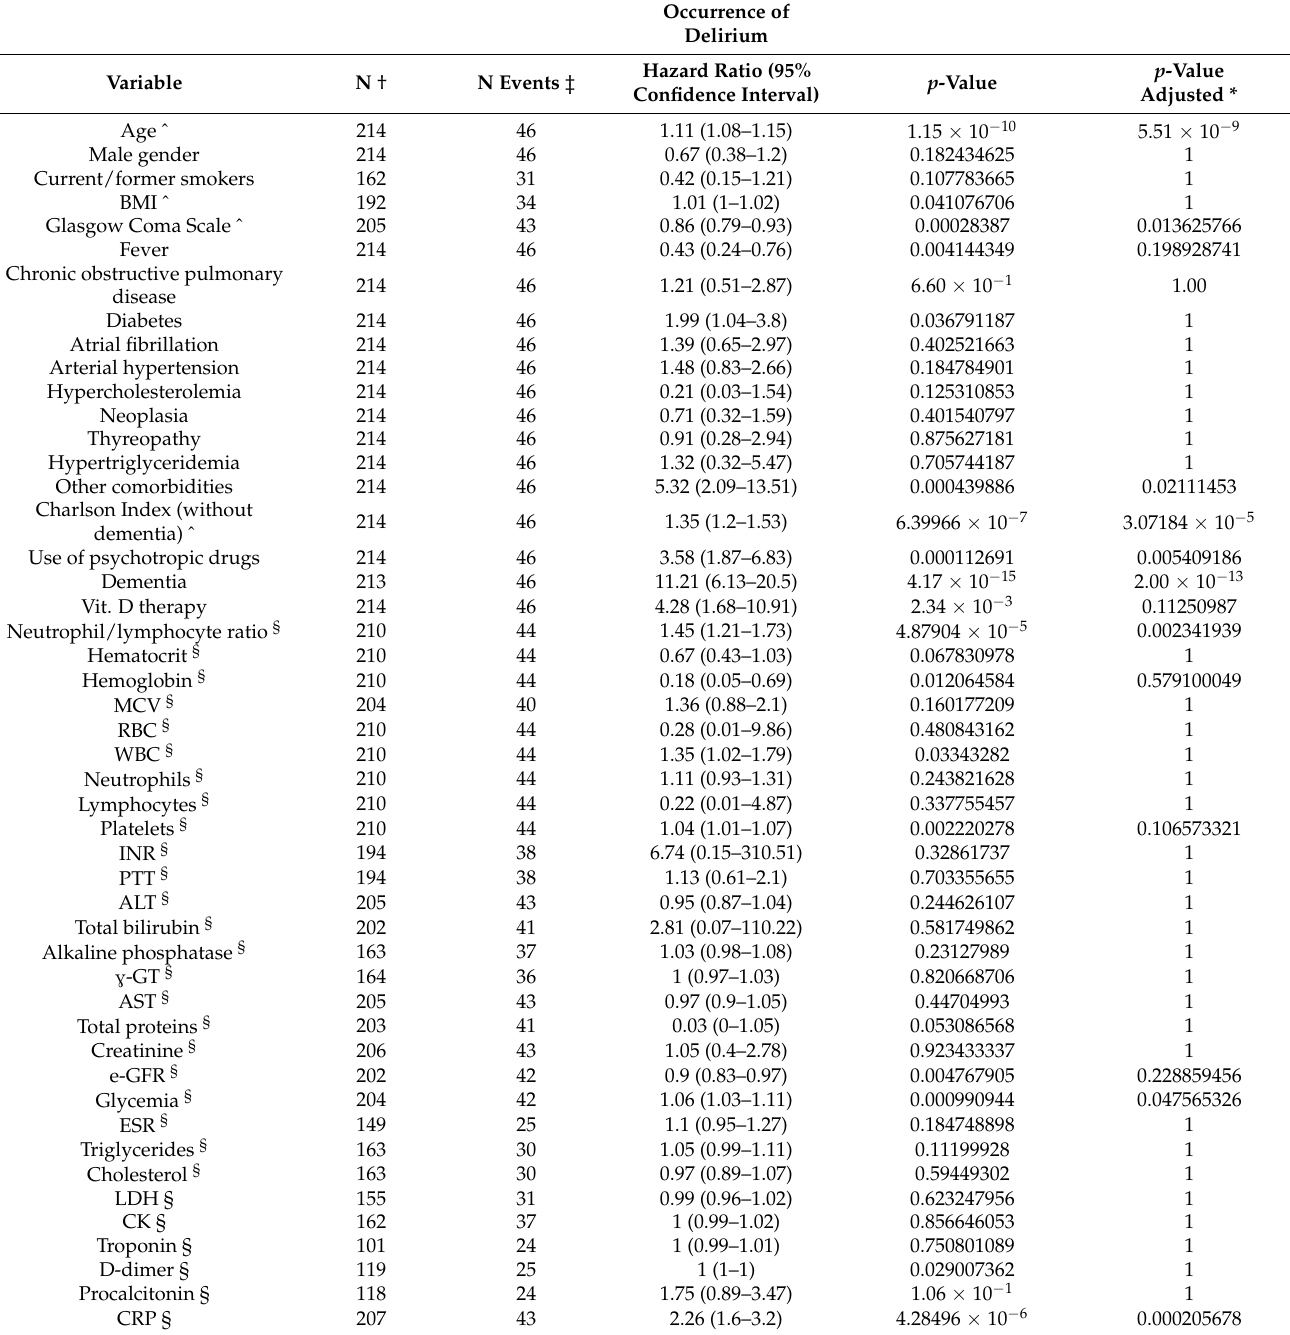
Table 3. Association between baseline clinical and laboratory variables and the diagnosis of